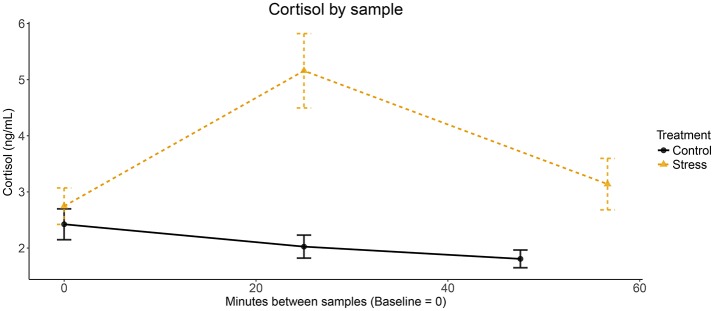
Cortisol levels over time.